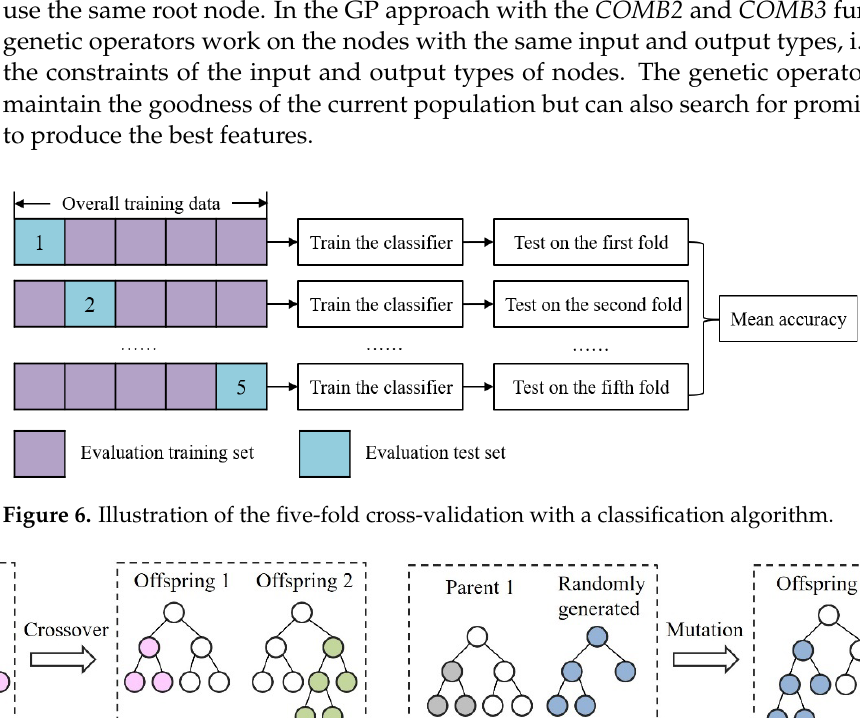
Figure 6. Illustration of the five-fold cross-validation with a classification algorithm.